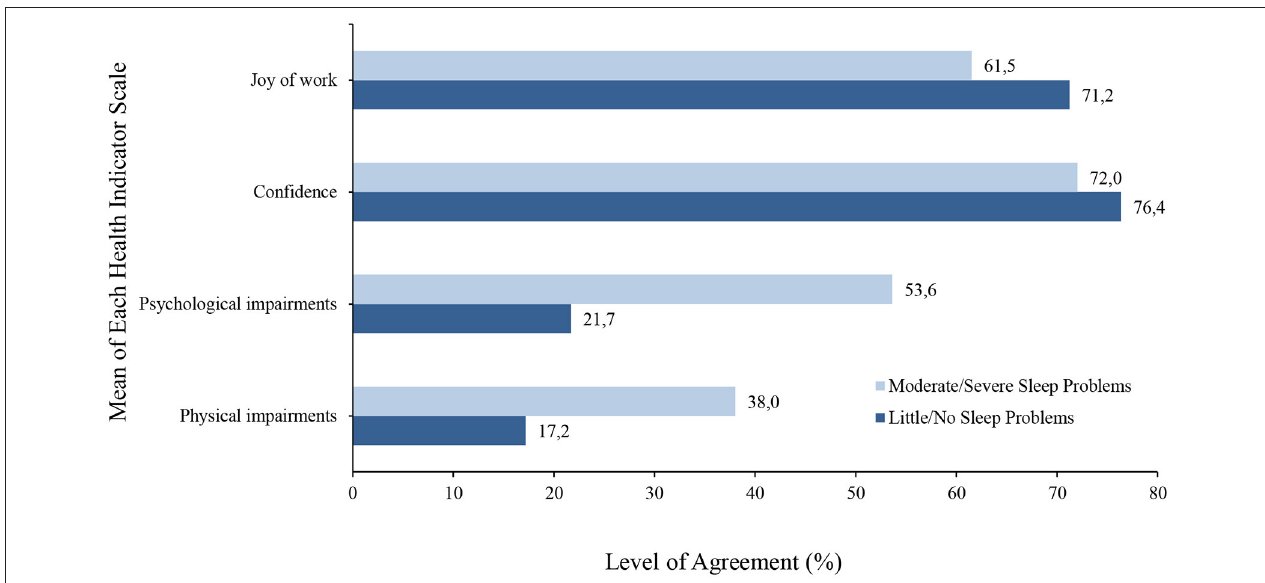
FIGURE 2 | A bar graph to show the mean level of agreement for each health indicator (scales that refer to positive health indicators are joy of work and confidence, negative health indicators are psychological and physical impairments that—depending on intensity and duration—can lead to illness or sick leave) in both good and poor